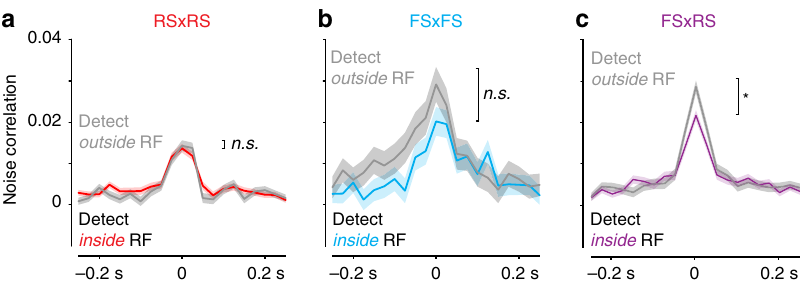
Fig. 5 Spatial and cell-type-speci fi c reduction in noise correlations. a Noise correlations between pairs of regular spiking (RS) neurons during probe stimulus presentation ( n = 797 pairs). Correlations for detect inside RF trials (red) versus detect outside RF (gray). Mean ± s.e.m. No signi fi cant difference in peak noise correlations (detect outside RF: 0.0143 ± 0.001; detect inside RF: 0.0137 ± 0.001; p = 0.98, Wilcoxon rank-sum test throughout fi gure). b As in a , between pairs of fast spiking (FS) neurons during stimulus presentation ( n = 95 pairs). No signi fi cant difference in peak noise correlations (detect outside RF: 0.029 ± 0.004; detect inside RF: 0.020 ± 0.003; p = 0.23, rank-sum test). c As in a , between pairs of regular spiking (RS) and FS neurons during stimulus presentation ( n = 608 pairs). Signi fi cant reduction in peak noise correlations during trials of detection inside RF (detect outside RF: 0.029 ± 0.002; detect inside RF: 0.022 ± 0.001; p < 0.001, rank-sum